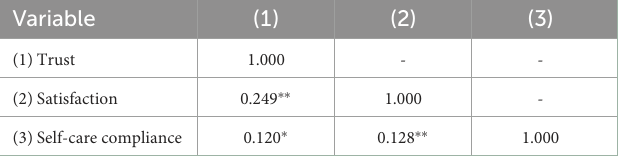
TABLE 3 Correlation coefficients among study